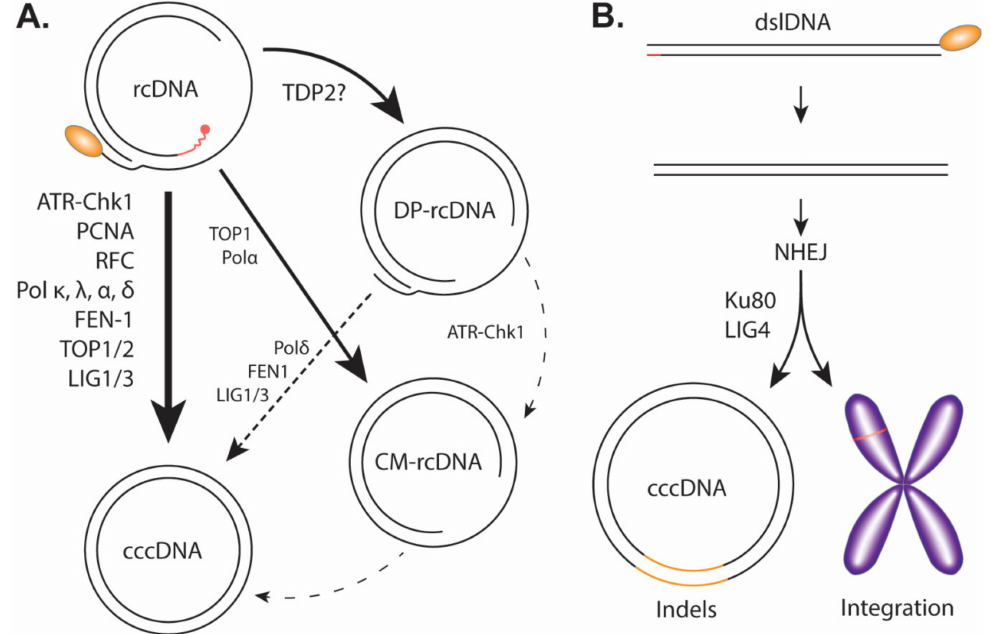
Figure 4. Proposed pathway of cccDNA formation. ( A ) Genuine cccDNA would be classified as